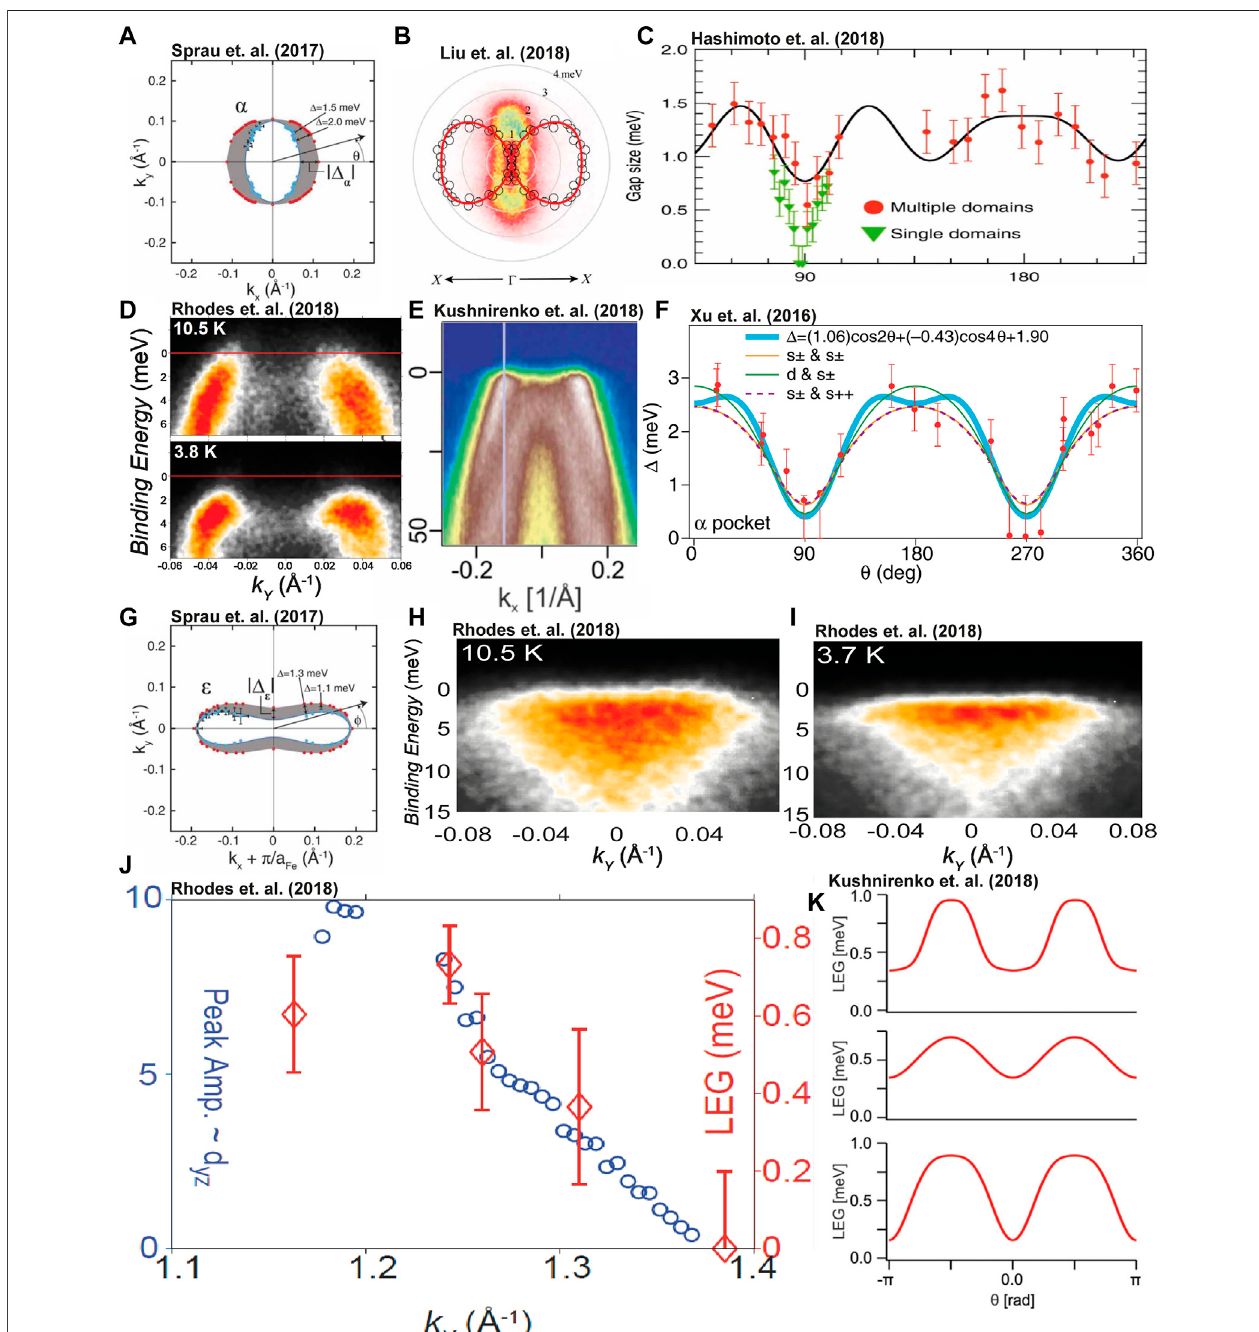
FIGURE8| Experimentalmeasurements ofthe superconducting gapofFeSe. (A) Angular dependence ofthegap around theholepocket asextractedfrom BQPI measurementsfromSprau et.al. [15]. (B) Angular dependence ofthegaparoundtheholepocketasextracted fromLaserARPESmeasurementsfromLiuet.al[18]. (C) Angular dependenceofthegaparoundtheholepocketfrom Hashimoto et.al. [17].Red dotsaredatafromatwinned sample,whereas greendatawasmeasured onan accidentally strained sample. (D) Band dispersion of the k z = 0hole band ( h ] =37 eV) from Rhodes et. al. [19] taken along the direction where the hole band gap is largest,aboveandbelow T c . (E) Equivalentbanddispersionofthe k z = π holeband( h ] =21 eV)below T c fromKushnirenko et.al. [20]. (F) Angulardependenceofthehole band ofFeSe 0.93 S 0.07 fromXu et.al. [16],showing equivalent momentumdependence asthe undoped sample. (G) Angular dependenceofthe gaparoundthe electron pocketasextractedfromBQPImeasurements fromSprau et.al. [15]. (H,I) Band dispersion alongtheminor lengthoftheelectron pocketabove andbelow T c ,alongthe high symmetryaxis from Rhodes et.al. [19]. (J) Comparison ofthegapmagnitude (Leading EdgeGap -LEG) and theintensity ofthespectral weight from Linear Vertical polarised light as a function of k x , which is directly correlated to the amplitude of d yz orbital weight. The gap is observed to decrease with decreasing d yz weight. Taken